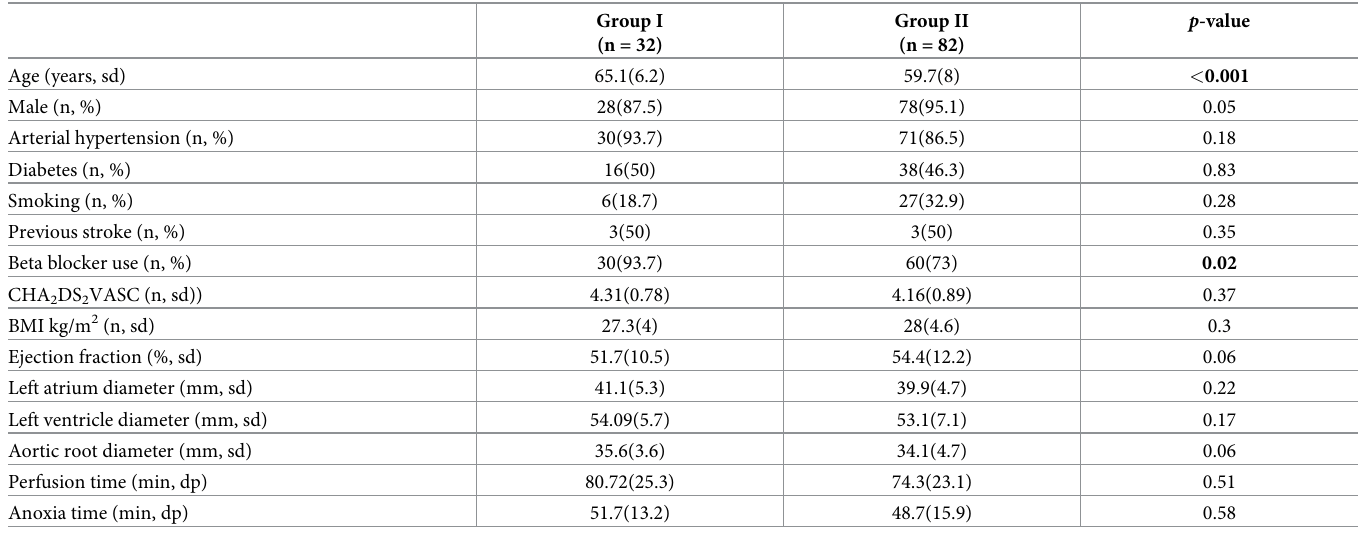
Table 1. Characteristics of the studied population.